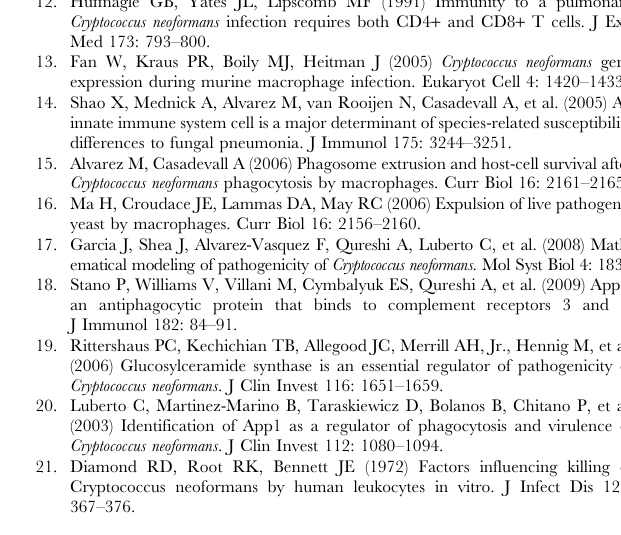
Figure S3 Mass spectrometry analysis of ceramide in HL-60. ( A ) Total levels of ceramide, in HL-60 undifferentiated (UD), differentiated (D) and HL-60 D treated with D609, as measured by LC-MS and normalized by nanomole of lipid inorganic phosphate (Pi). ( B ) Specific lipid species for ceramide (16:0) in HL- 60 undifferentiated (UD), differentiated (D) and HL-60 D treated with D609, as measured by LC-MS and normalized by Pi. * P , 0.05 compared UD cells. Figure S4 Quantitative analysis of Western blot of Pkd1 in Figure 5B. Intensity of the bands were calculated using LabWork Software. AU, arbitrary units.